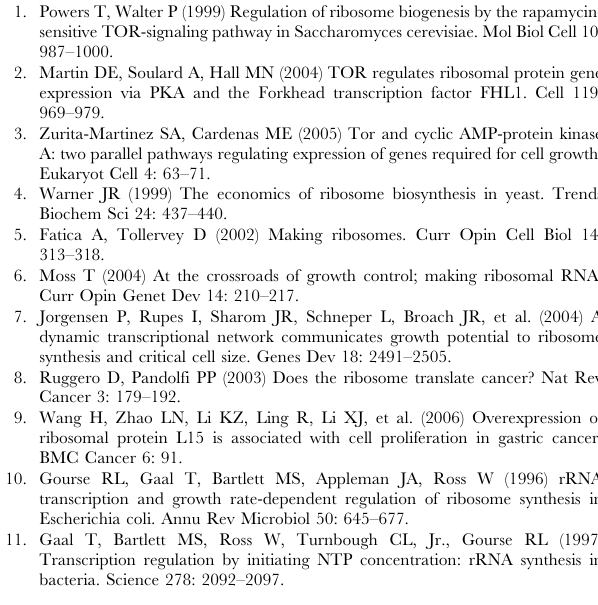
Table S1 List of gene modules